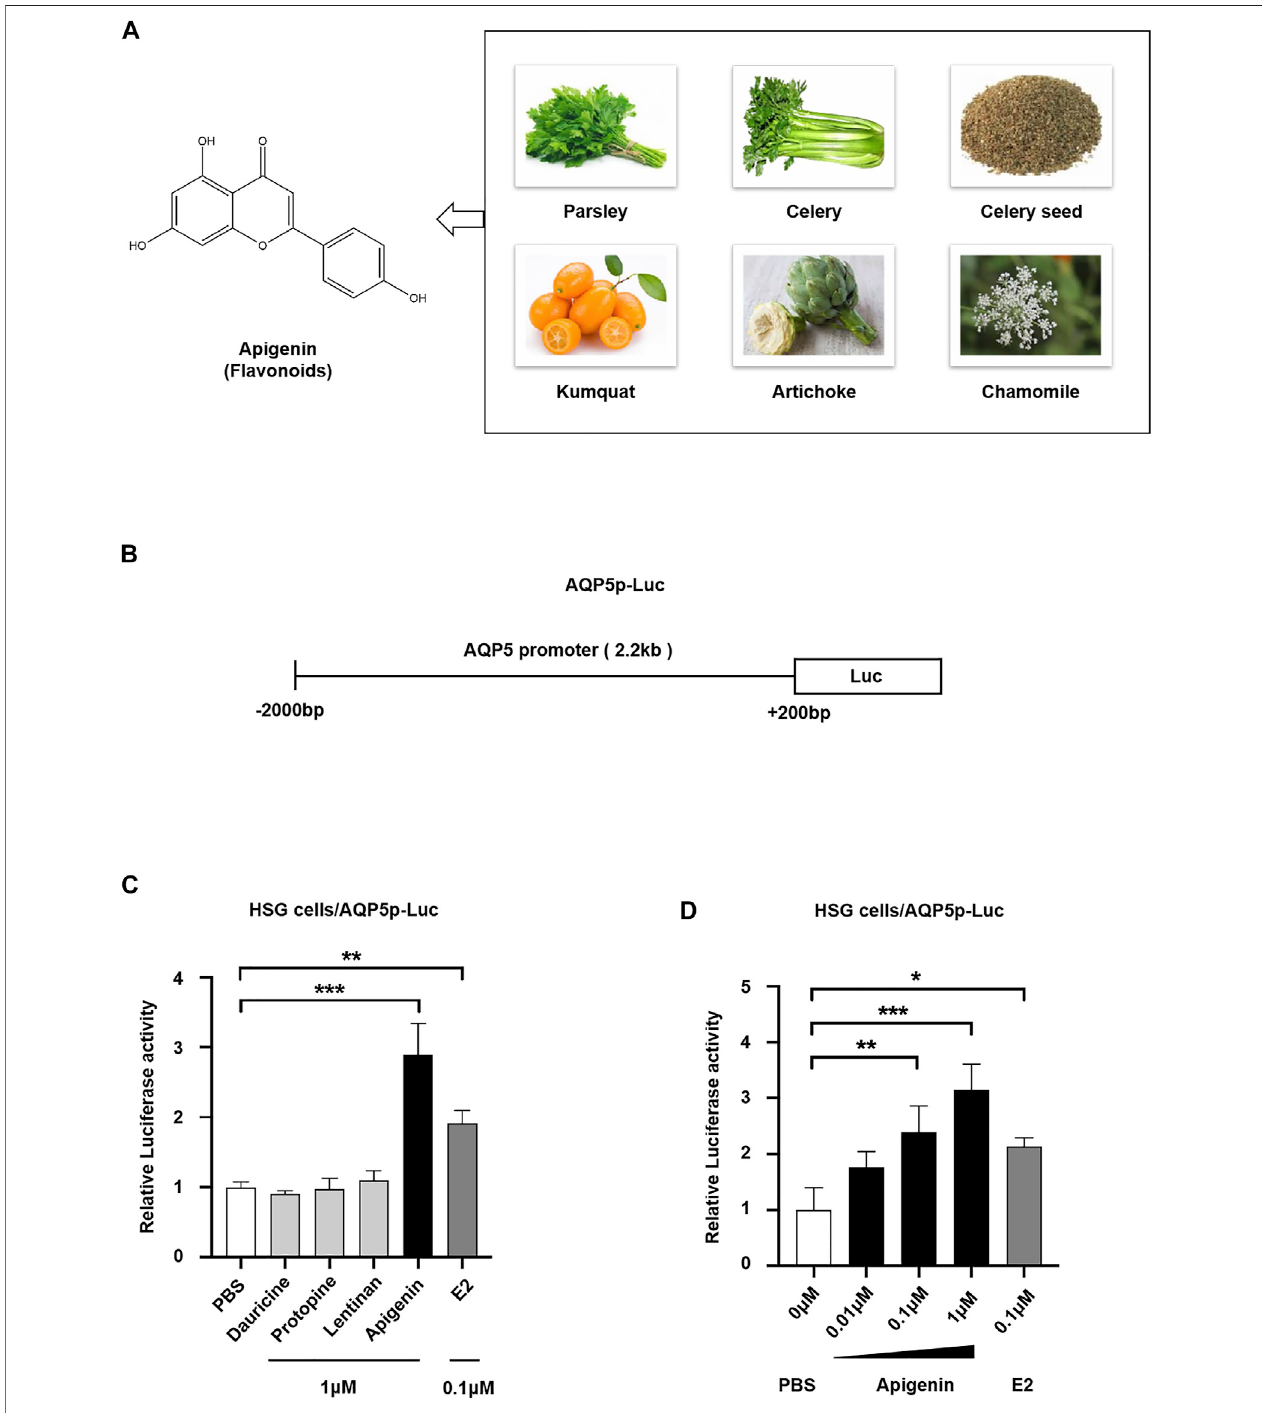
FIGURE 1 | Natural product apigenin upregulates AQP5 transcription. (A) Structure of apigenin. (B) Luciferase reporter pGL3/AQP5 promoter (AQP5p) plasmid. (C) Relative luciferase activity showing the AQP5p activation induced by apigenin in HSG cells. (D) Apigenin activated the AQP5p in dose dependence. Data are presented as the mean ± SD, n = 3. Signi fi cant effect of the treatment, * p < 0.05, ** p < 0.01.